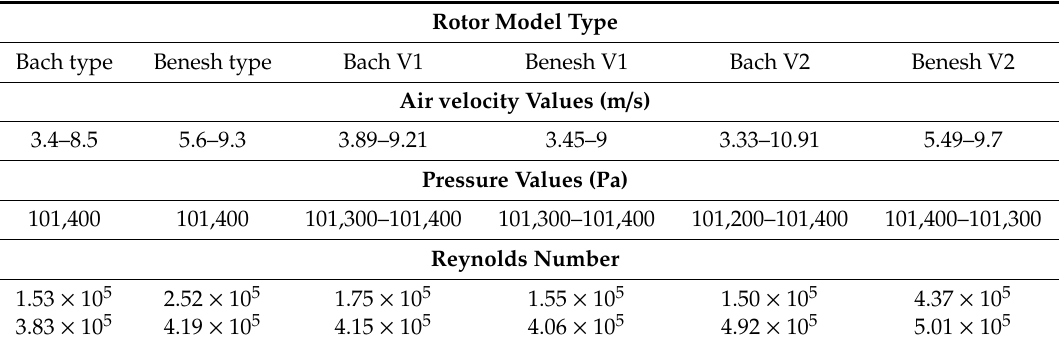
Table 6. Velocity and pressure result values for analyzed rotor model types.